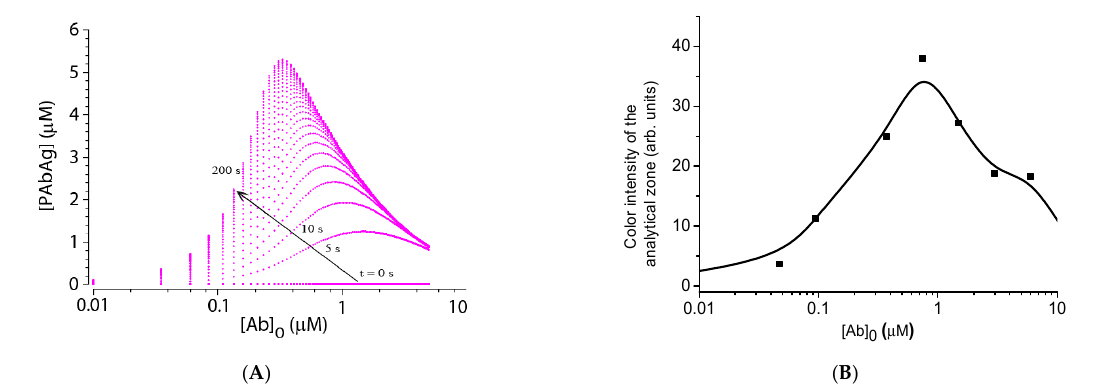
Figure 6. Calibration dependences of analyte determination. ( A ) Theoretical calibration dependence obtained by numerical modeling. Model parameters: T = 60 s; [P] 0 = 5 × 10 − 7 M; [Ag] 0 = 10 − 5 M; ka = 10 5 1/(M*s); kd = 2.5 × 10 − 3 1/s. ( B ). Experimental values of the color intensity of the analytical zones after the assay (signal from the Reflekom analyzer).